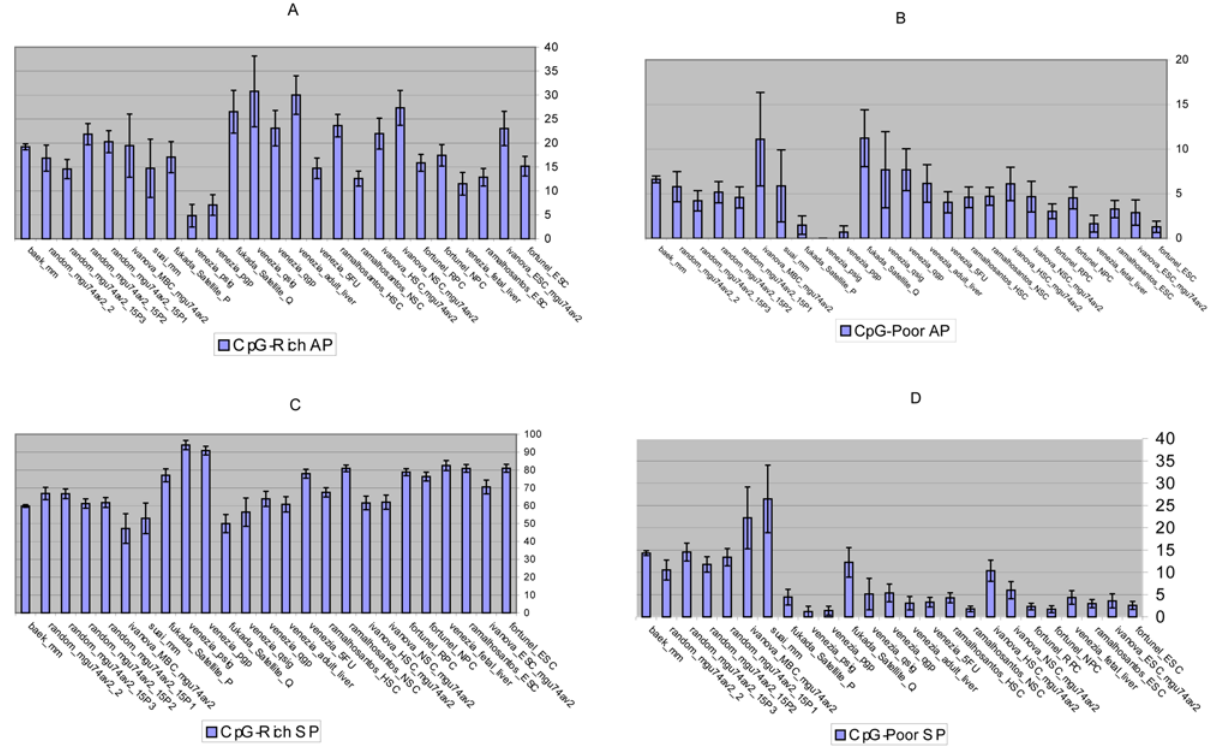
Figure 2. The distribution of genes classed according to the four promoter types (A) CpG-rich AP, (B) CpG-poor AP, (C) CpG-rich SP and (D) CpG-poor SP. The standard error for the percentages are calculated using the equation (p*(100 2 p)/n) 0.5 where p is the percentage of genes that belong to a given promoter type and n is the total number of genes classified. The standard errors for the percentages are plotted as error bars. See Fig S1 .